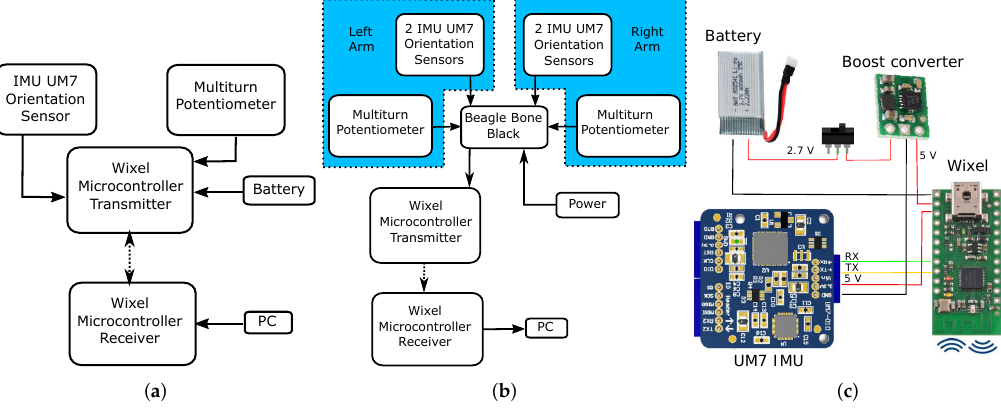
Figure 3. Communication diagrams of the arm motion-tracking system prototypes: ( a ) the 4-DOF system (Phase 1) [22] and ( b ) the 7-DOF double-arm system used in [30] (Phase 2). ( c ) Electronic design of an IMU sensor module (Phase